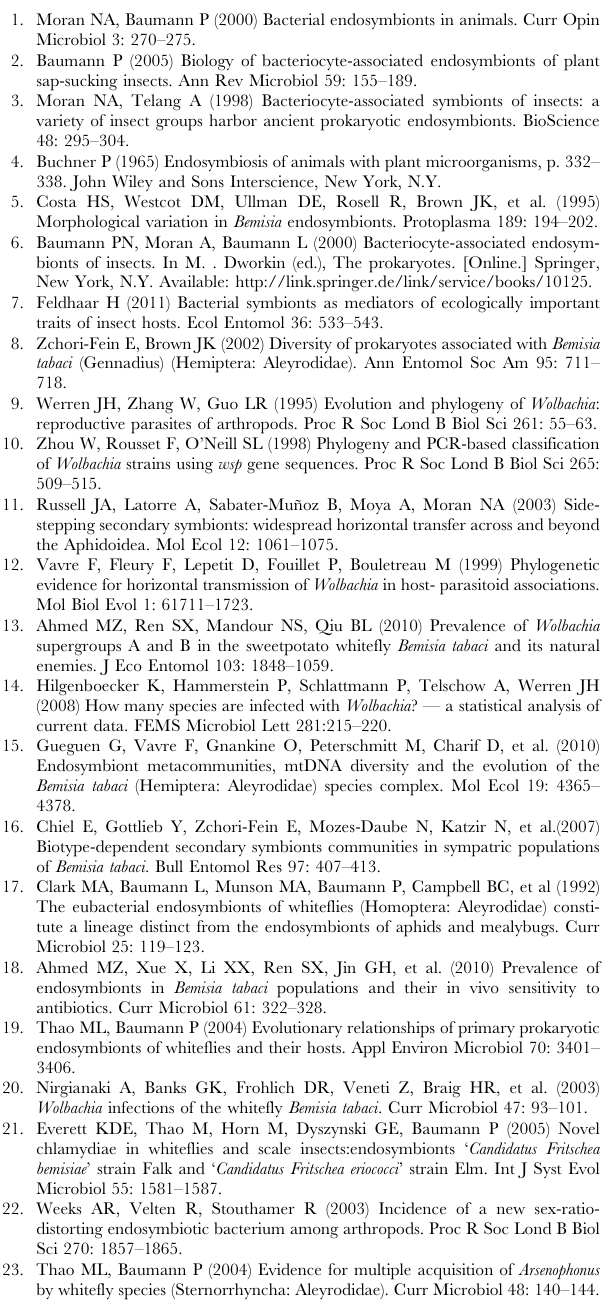
using maximum-likelihood analysis under the K2 + G substitution model. The bootstrap values are indicated. (DOC) Figure S2 The exact search at best reconstructions using TreeMap 2.0b show the ML phylogenetic compar- ison of endosymbionts over their hosts. Endosymbionts displayed in black and the hosts in light grey; in reconstruction; cospeciation events are shown by ( N ), duplications by( & ) and host switches by ( R ). A. Host B. tabaci and its P-endosymbionts. B. Host B. tabaci and its Wolbachia ( wsp ). C. Host B. tabaci and its Wolbachia ( ftsZ ). D. Host B. tabaci and its Arsenophonus (23S). E. Host B. tabaci and its Cardinium (16S).